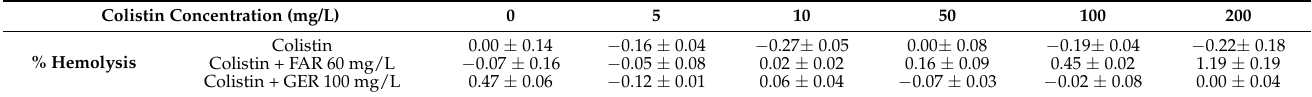
Table 5. Hemolytic activity of colistin (% of triton x-100 positive control) for different concentrations of pure colistin solution or in the presence of LNP to obtain 60 mg/L of FAR or 100 mg/L of GER. Values presented are means +/ − SD ( n = 3). Colistin Concentration